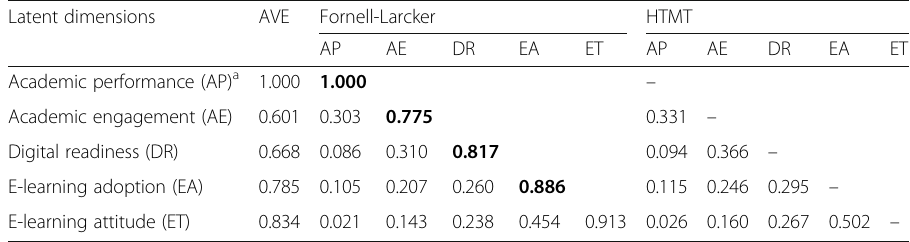
Table 3 Discriminant validity analysis Latent dimensions